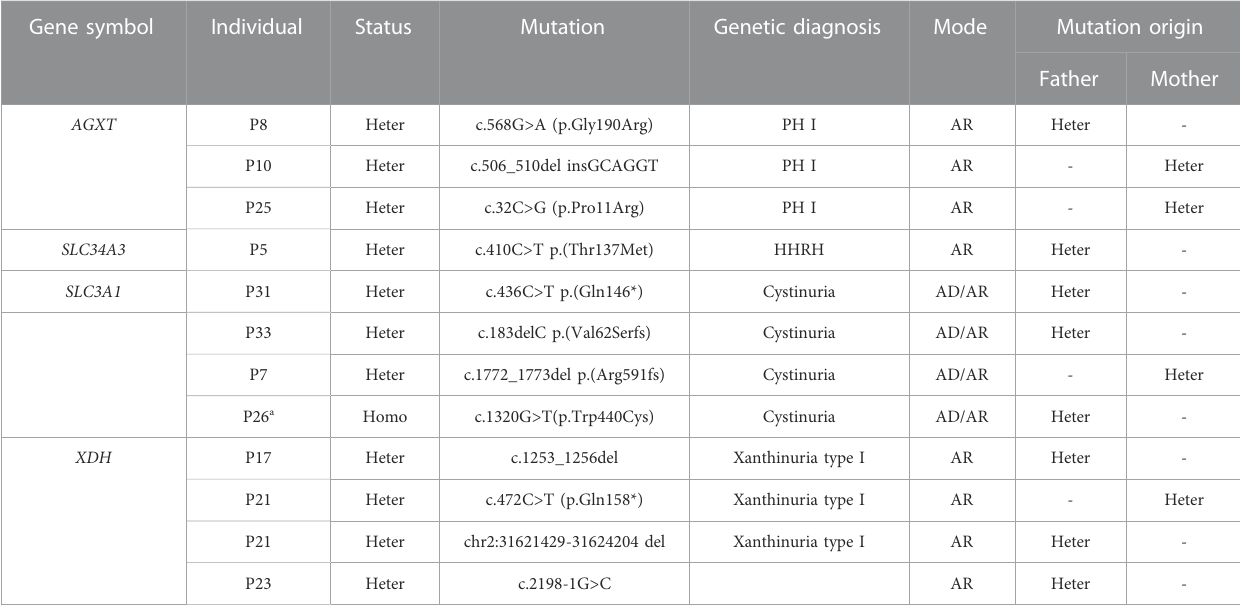
TABLE 3 Likely pathogenic mutations of four genes detected in 11